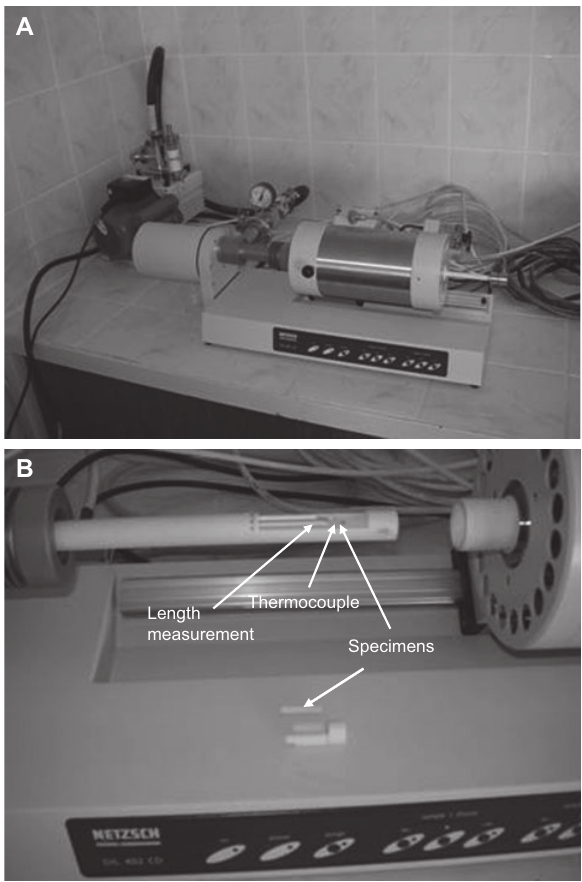
Figure 2 Measuring of flow diameter of SCC and SCLC after slump flow test. Figure 3 (A and B) Dilatometer used in the